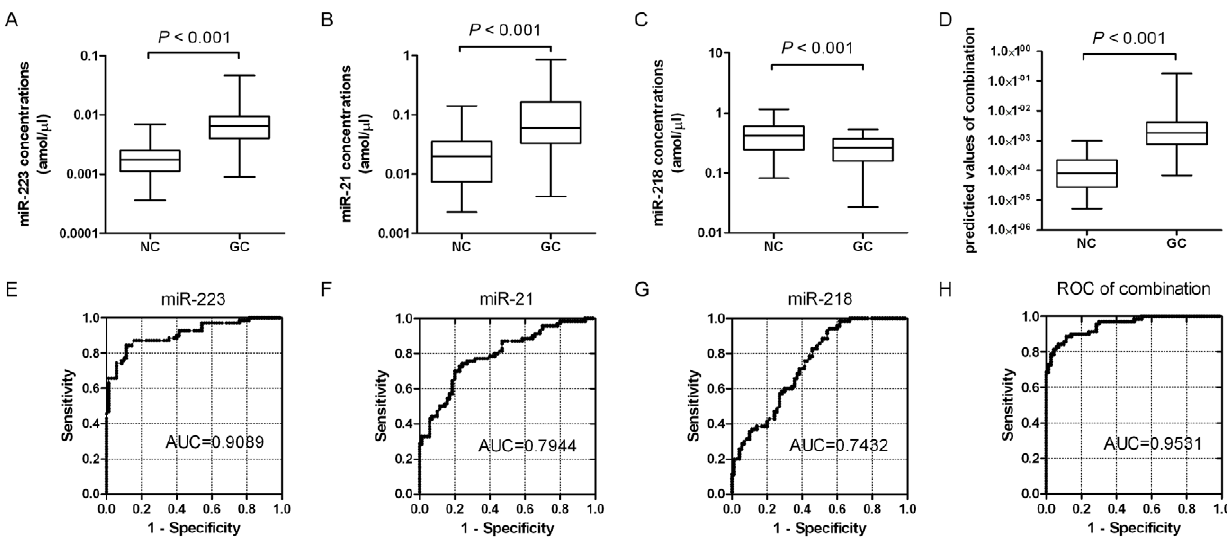
Figure 3. Validation of the plasma levels of miR-223, miR-21 and miR-218 in large scale. Box plots show the plasma concentrations of miR-223 (A) , miR-21 (B) , miR-218 (C) and (miR-223 6 miR-21)/miR-218 (D) in GC patients (GC, n=70) and healthy controls (NC, n=70). The lines inside the boxes denote the medians. The whiskers of box plots: Min to Max. Graphs of receiver operating characteristics (ROC) curve show the area under the curves (AUCs) of miR-223 (E) , miR-21 (F) , miR-218 (G) and (miR-223 6 miR-21)/miR-218 (H) for distinguishing the GC patients from the healthy controls. The interval between the 5 th and 95 th percentiles denotes the confidence level and the report results show as Fraction. All assays were repeated three times in duplicates.